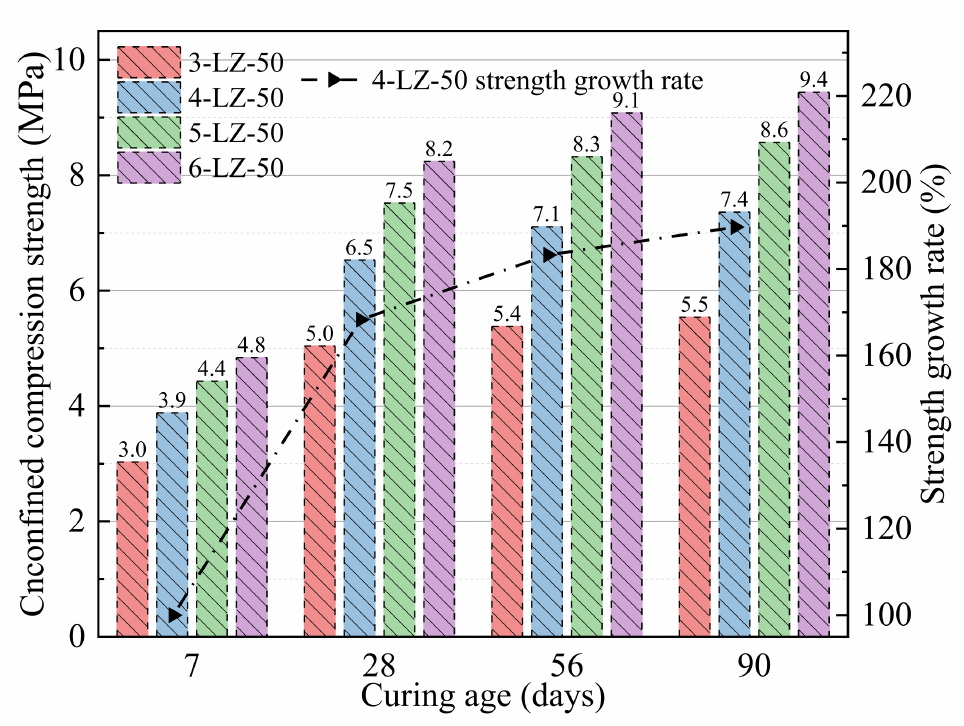
Figure 5. Unconfined compressive strength test results of specimens with different cement